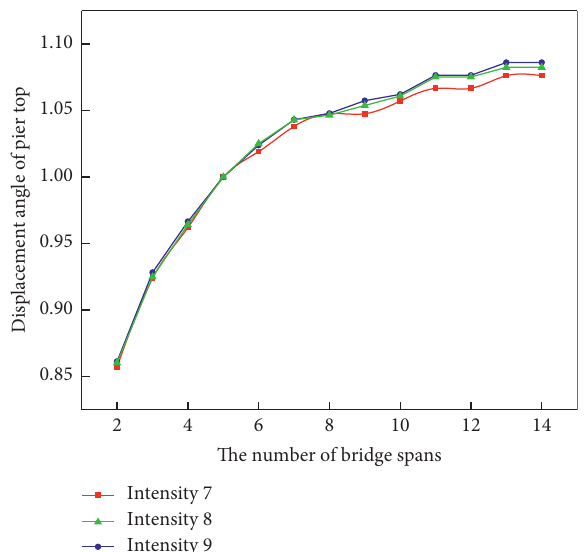
Figure 2: Influence of span number on displacement angle of bridge pier top.